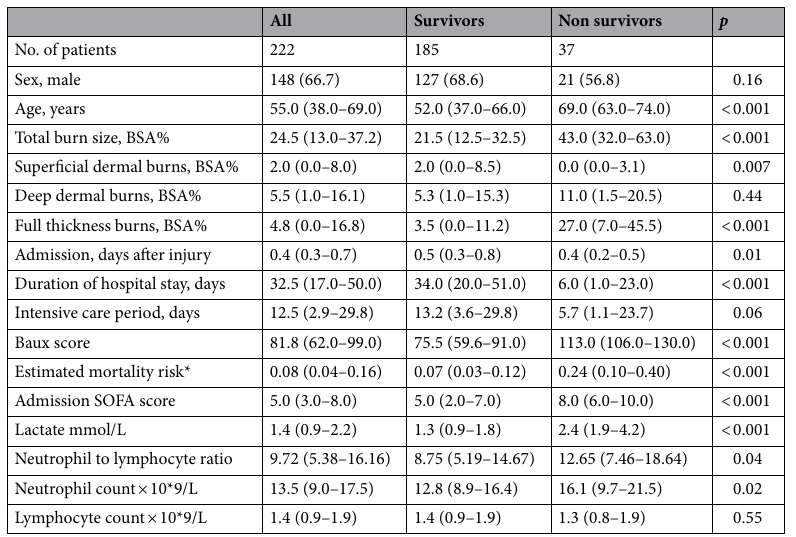
Table 1. Description of the patients. Data are presented as median (25th–75th centiles) or n (%). BSA, body surface area. SOFA score, Sequential organ failure assessment score. *EMR SAPS